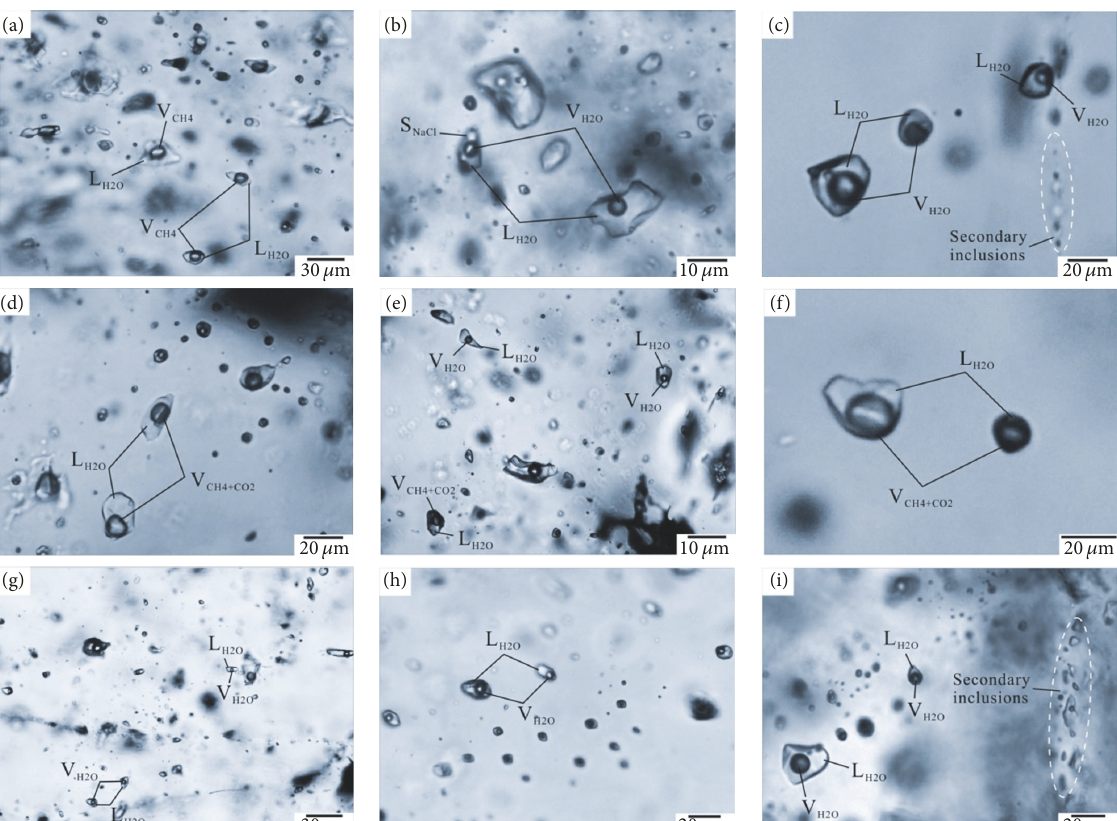
Figure 5: Photomicrographs of fluid inclusions in Stages 1–3 quartz and fluorite in the Bairendaba Ag-Zn-Pb deposit. ((a), (b), (c)) Type Ι , Type III, and Type Ι V inclusions in Stage 1 quartz. ((d), (e)) Type ΙΙ and Type III inclusions in Stage 2 - 1 quartz. ((f), (g)) Type ΙΙ and Type III inclusions in Stage 2 - 1 quartz. ((h), (i)) Type III inclusions in Stage 3 fluorite. L (liquid phase), V (vapor phase), and S (halite